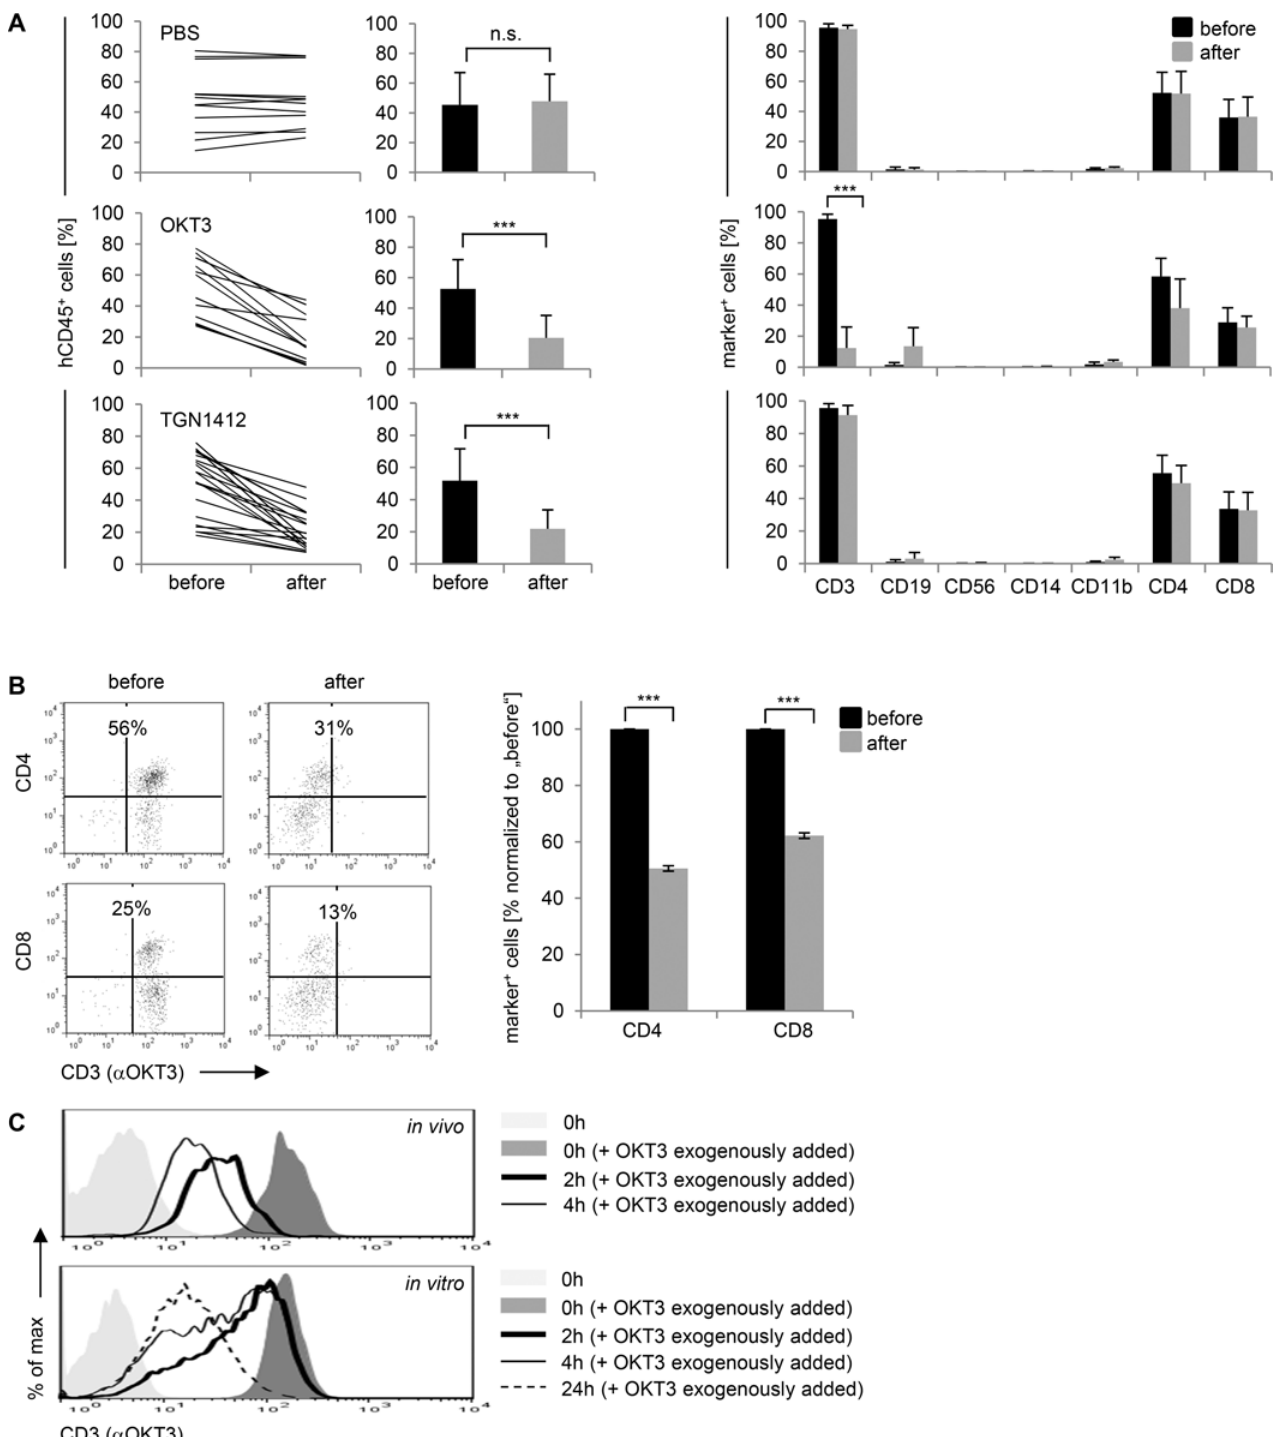
Fig 2. Loss of hCD45 + or hCD3 + cells from the peripheral blood upon TGN1412 or OKT3 treatment. Humanized mice were injected i.v. with 20 μ g OKT3 or 20 μ g TGN1412 per 10 grams body weight. (A) Before (black bars) and 2 – 6 hours post OKT3 (n = 11 – 12) or TGN1412 (n = 18 – 20) application (time point of sacrifice; gray bars), percentage and composition of hCD45 + cells in peripheral blood of reconstituted mice were analyzed by flow cytometric analysis. PBS-treated mice (n = 12) were used as control. Each line represents an individual mouse. *** p < 0.001; n.s., not significant (paired t-test for difference after-before). (B) Before and 4 hours post OKT3 application (n = 3) CD3 expression on hCD4 + or hCD8 + T cells in peripheral blood of humanized